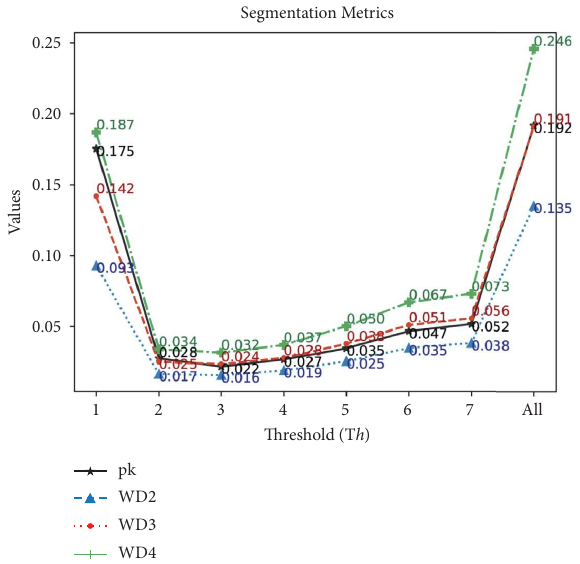
Figure 7: Segmentation metrics results according to diferent thresholds. Table 6: Results comparison with the TSHD algorithm. Method